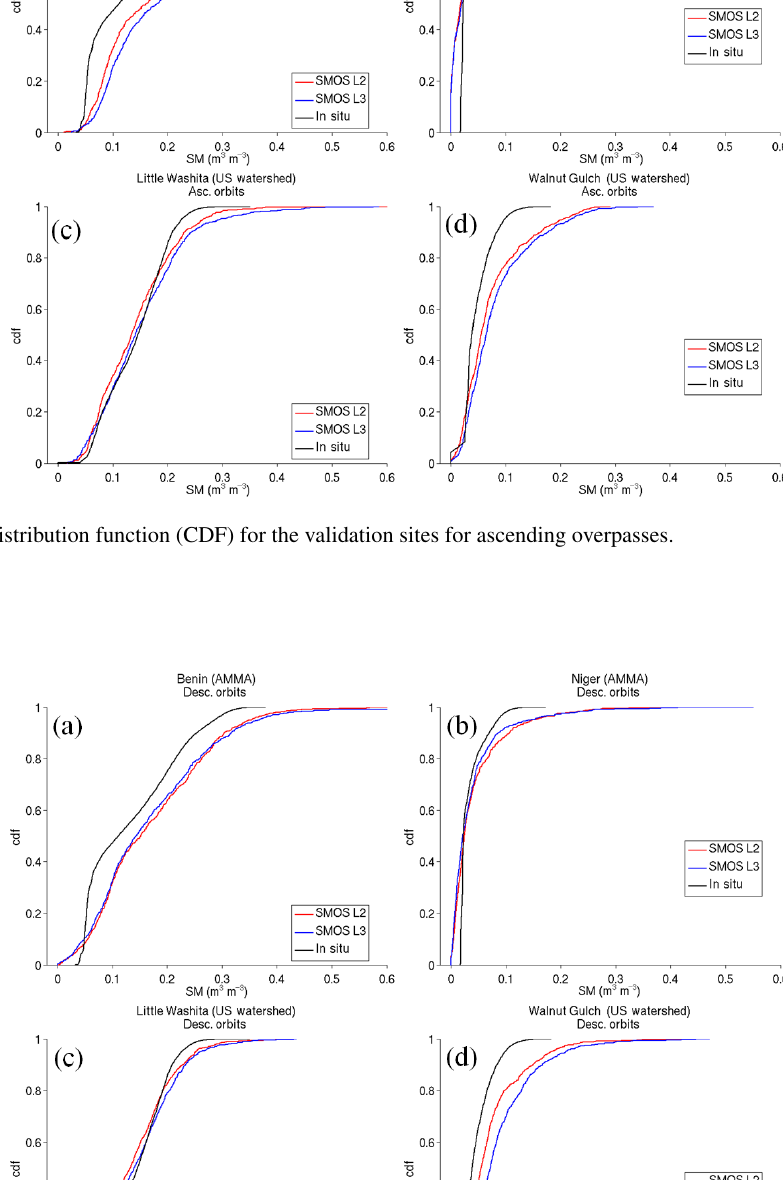
Earth Syst. Sci. Data, 9, 293–315, 2017